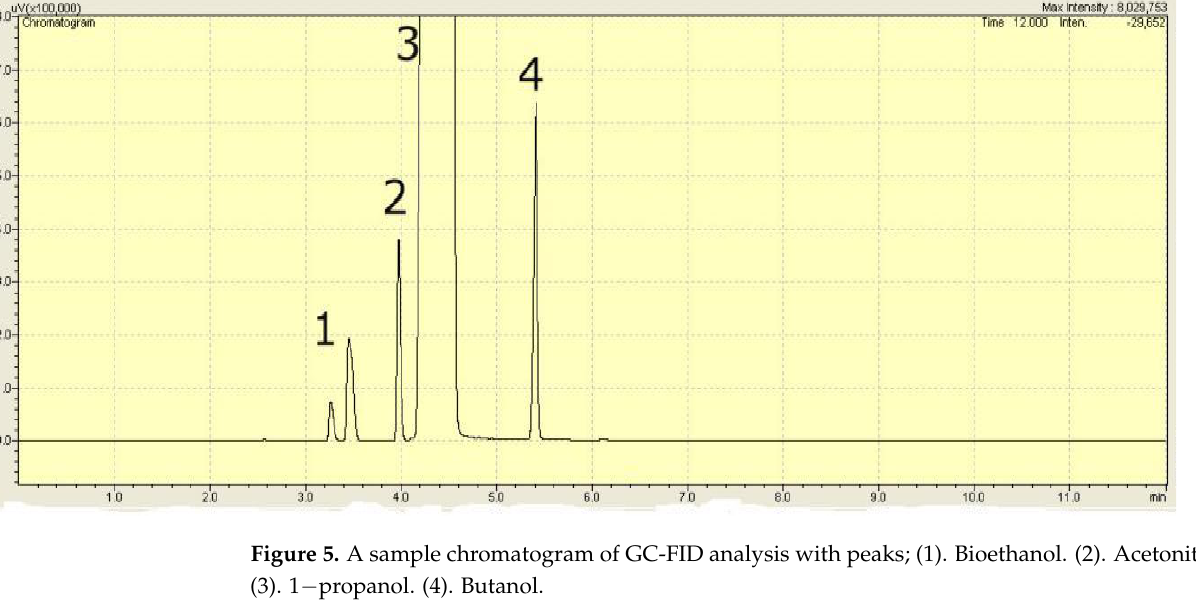
Figure 4. FTIR spectra of ( a ) Onion extract. ( b ) Bioethanol from S. cerevisiae. ( c ) Bioethanol from P. pastoris. ( d ) Bioethanol from Co-culture strain.